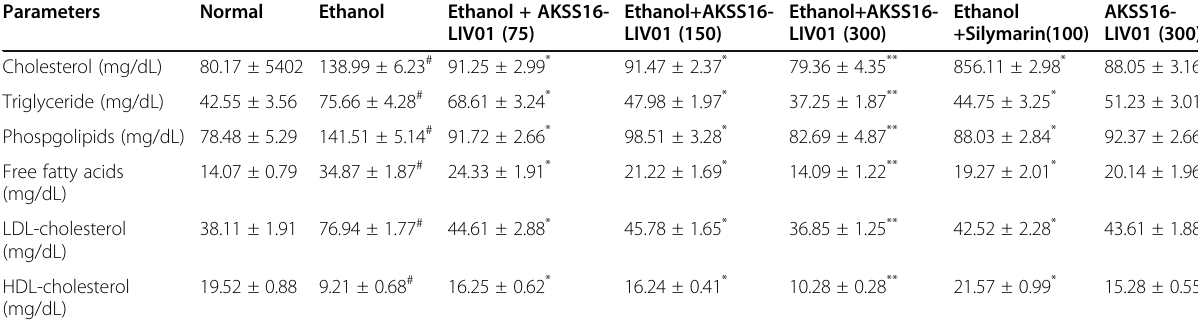
Table 6 Effect of AKSS16-LIV01 on concentrations of nonenzymatic biochemical parameters in chronic ethanol-induced hepatic damage in mice Parameters